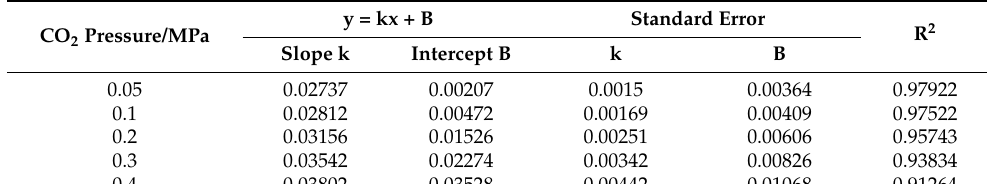
Figure 5. Test results and kinetic model of regression analysis.